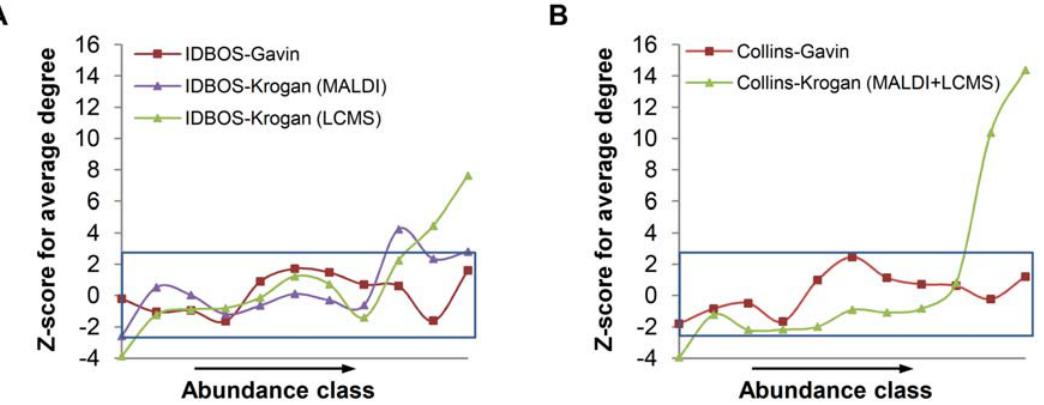
Figure 3. Abundance effects in high-confidence PINs derived from AP/MS data. The association between protein degree and abundance in high-confidence PINs derived by (A) the IDBOS procedure (this work) and (B) Collins et al. [16], from AP/MS data sets of Gavin et al. [8] and Krogan et al. [9]. Proteins were sorted by increasing abundance, as measured by Newman et al. [30], into 11 classes. Undetectable low-abundant proteins comprised class 0 while the remaining proteins were sorted into 10 equally-sized classes. The sizes of classes 0/classes 1–10 were as follows: 231/92 for the IDBOS-Gavin PIN; 265/68 for the IDBOS-Krogan (MALDI) PIN; 424/101 for the IDBOS-Krogan (LCMS) PIN; 238/87 for the Collins-Gavin PIN; and 384/111 for the Collins-Krogan (MALDI + LCMS) PIN. For each class, we determined the significance of the average degree, as a Z-score, compared to the network average and standard deviation determined from equivalently-sized randomly-compiled pools (10 4 realizations). The enclosed rectangular areas represent |Z| , 2.6 (P . 0.05 after multiple-test